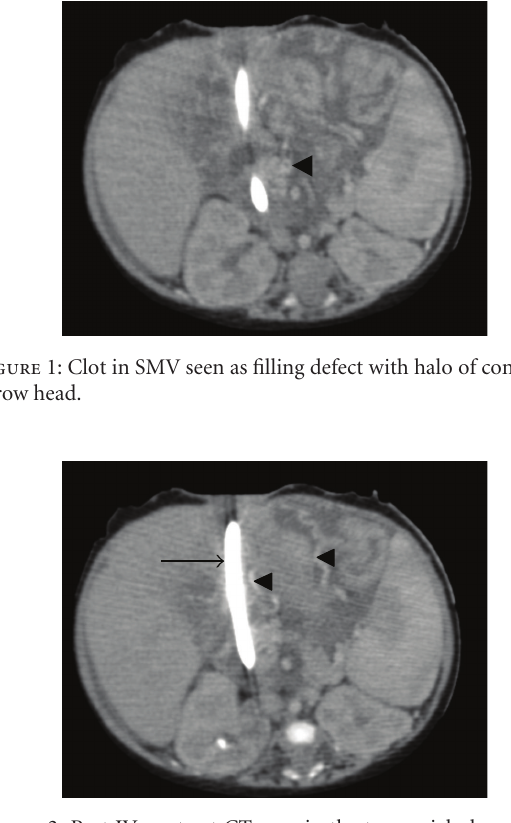
Figure 2: Post IV contrast CT scan in the transaxial plane. Arrow heads point to venous collaterals. Large arrow points to gastrostomy